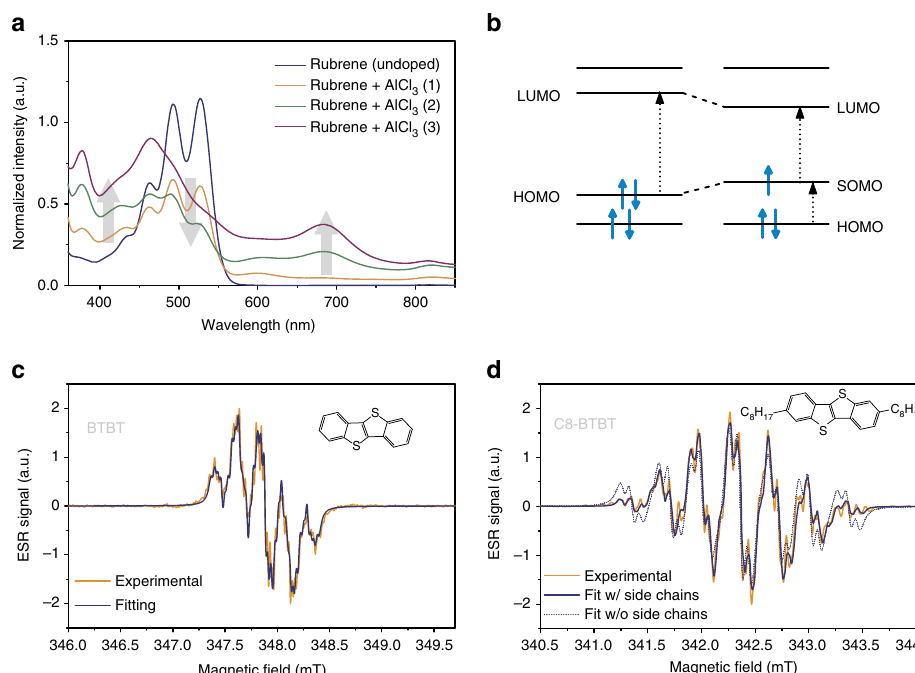
Figure 1 | ESR and optical spectra of doped molecules. ( a ) Optical absorption spectra of a 0.5 (cid:4) 10 (cid:2) 3 moll (cid:2) 1 solution of rubrene in dichloromethane with increasing amounts of AlCl 3 (traces 1–3). We observe the expected bleaching of the transition between the highest occupied molecular orbital (HOMO) and the lowest unoccupied molecular orbital (LUMO) together with the emergence of charge induced transitions in the sub band gap regime from the HOMO to the singly occupied molecular orbital (SOMO). The grey arrows emphasize the increase of charge induced absorption and the decrease of the neutral molecule absorption peaks with higher doping levels. ( b ) A schematic of energy levels with possible optical transitions for a neutral and positively charged molecule. The shifts of the HOMO and LUMO energy levels reflects the reorganization of the molecular geometry to accommodate the charge. ( c , d ) Derivative ESR spectra of BTBTand C8-BTBTwith best fits including (solid line) or excluding (dashed line) HFI from the first two hydrogens on the side